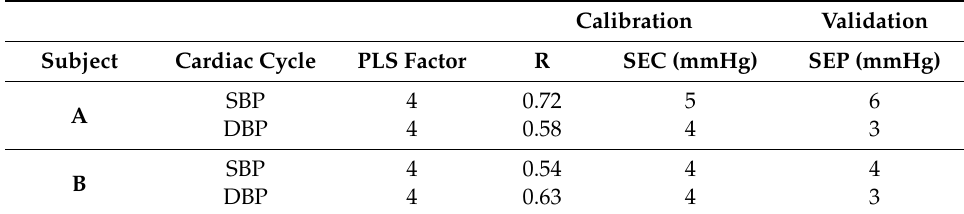
Table 3. Calibration and validation results for each subject.